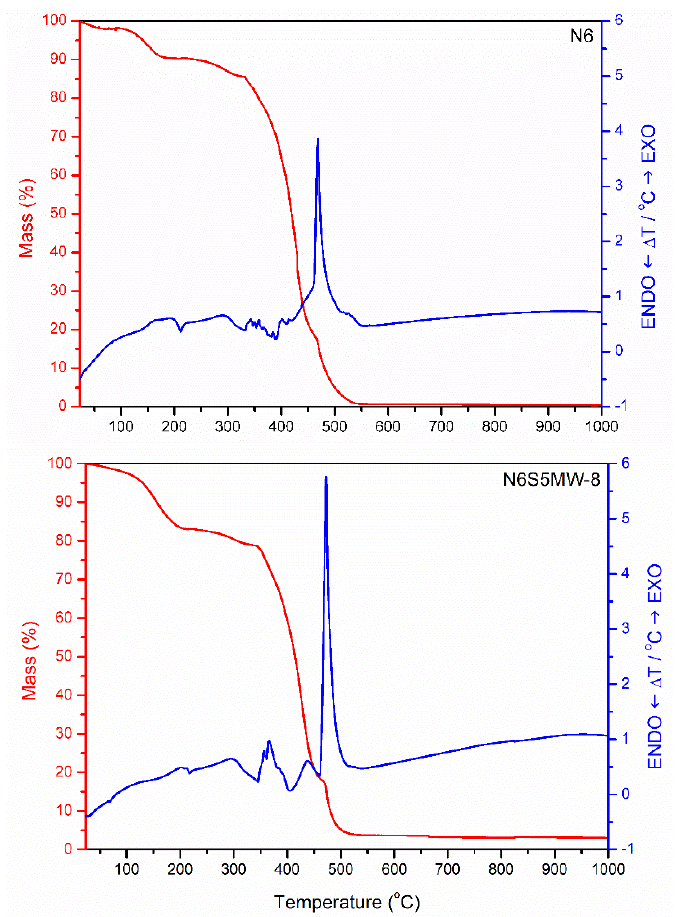
Figure 10. TG–DTA curves of sample N6 ( top ) and N6S5MW-8 ( bottom ).